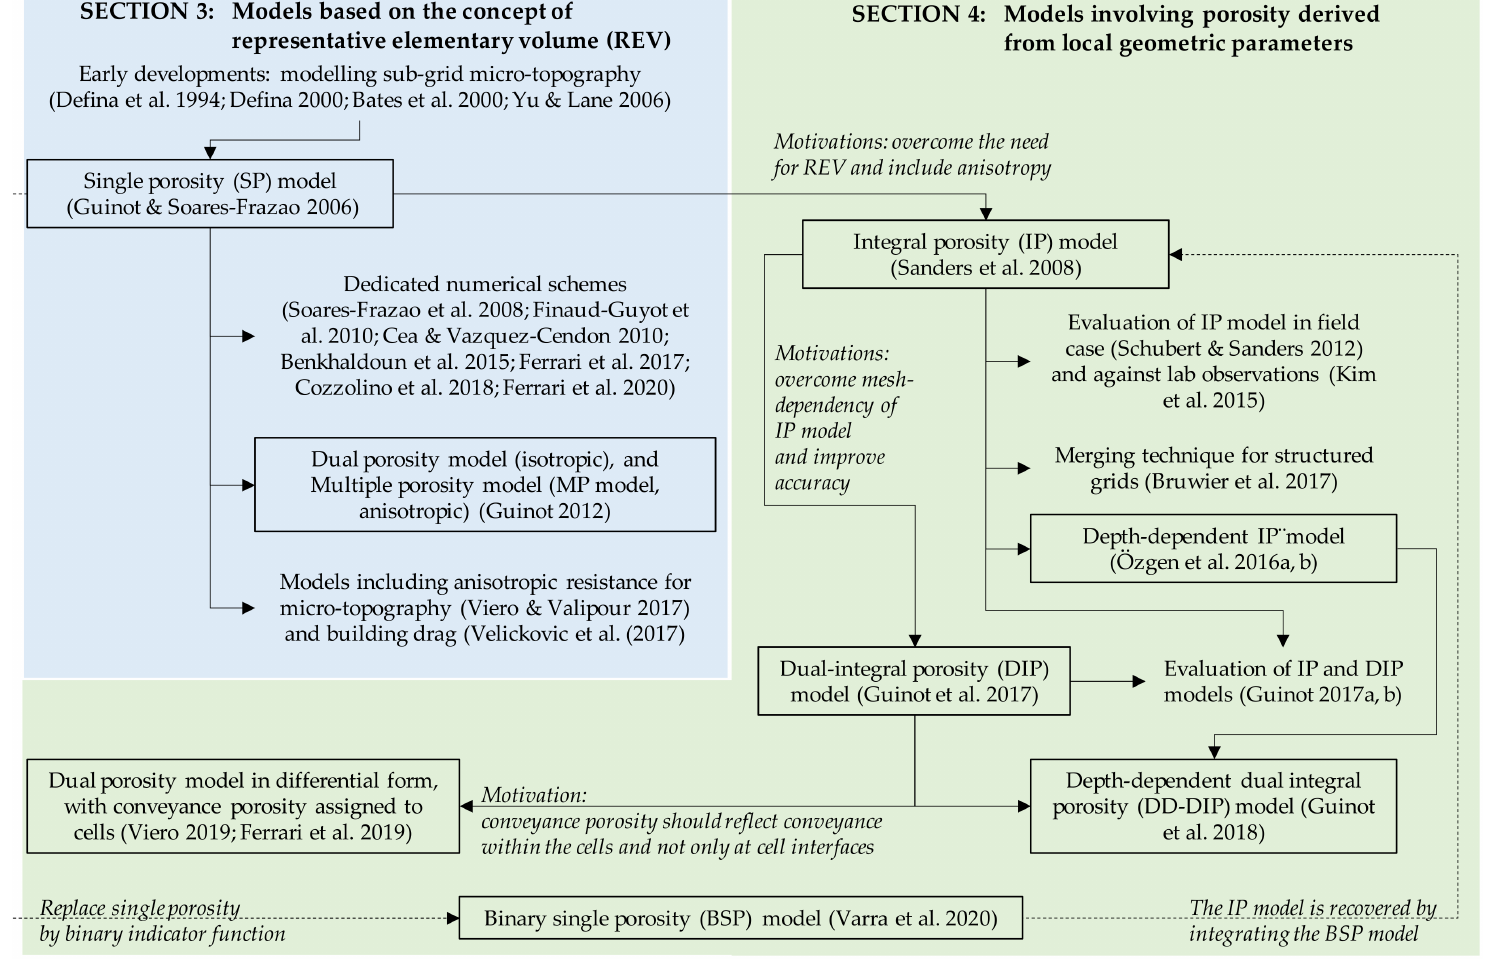
Figure 2. Articulation between selected major contributions to the development of porosity shallow-water models for large-scale urban flood